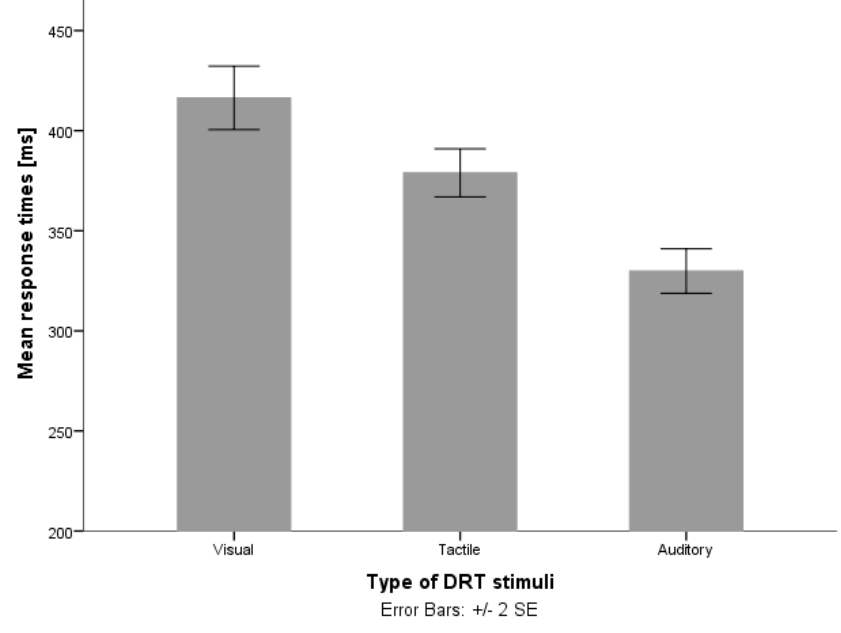
Figure 1. Mean response times for visual, tactile and auditory stimuli [10].